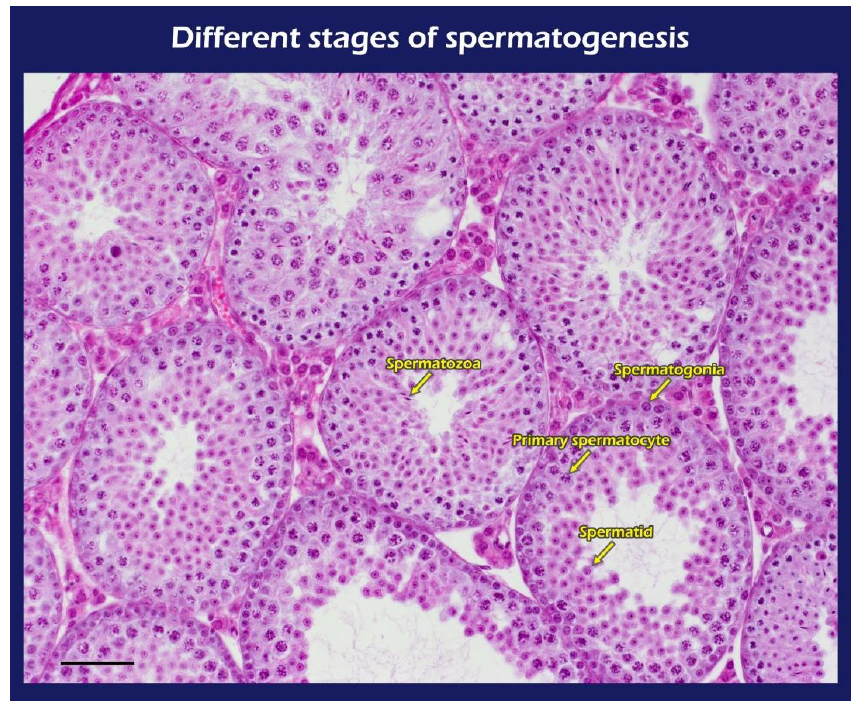
Figure 3. Typical different types of germ cells during spermatogenesis including spermatogonia, primary spermatocyte, spermatid, and spermatozoa (yellow arrow). Bar = 60 um.